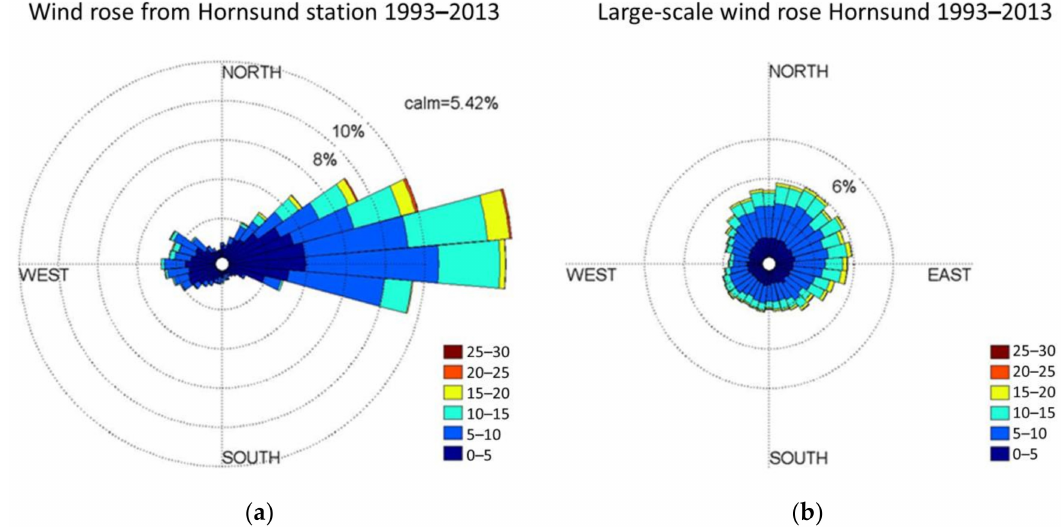
Figure 12. Local wind rose for ( a ) Hornsund station for the years 1992–2013, and ( b ) large-scale wind rose (from NCEP/NCAR reanalysis) interpolated for the position of the Hornsund station for the years 1993–2013